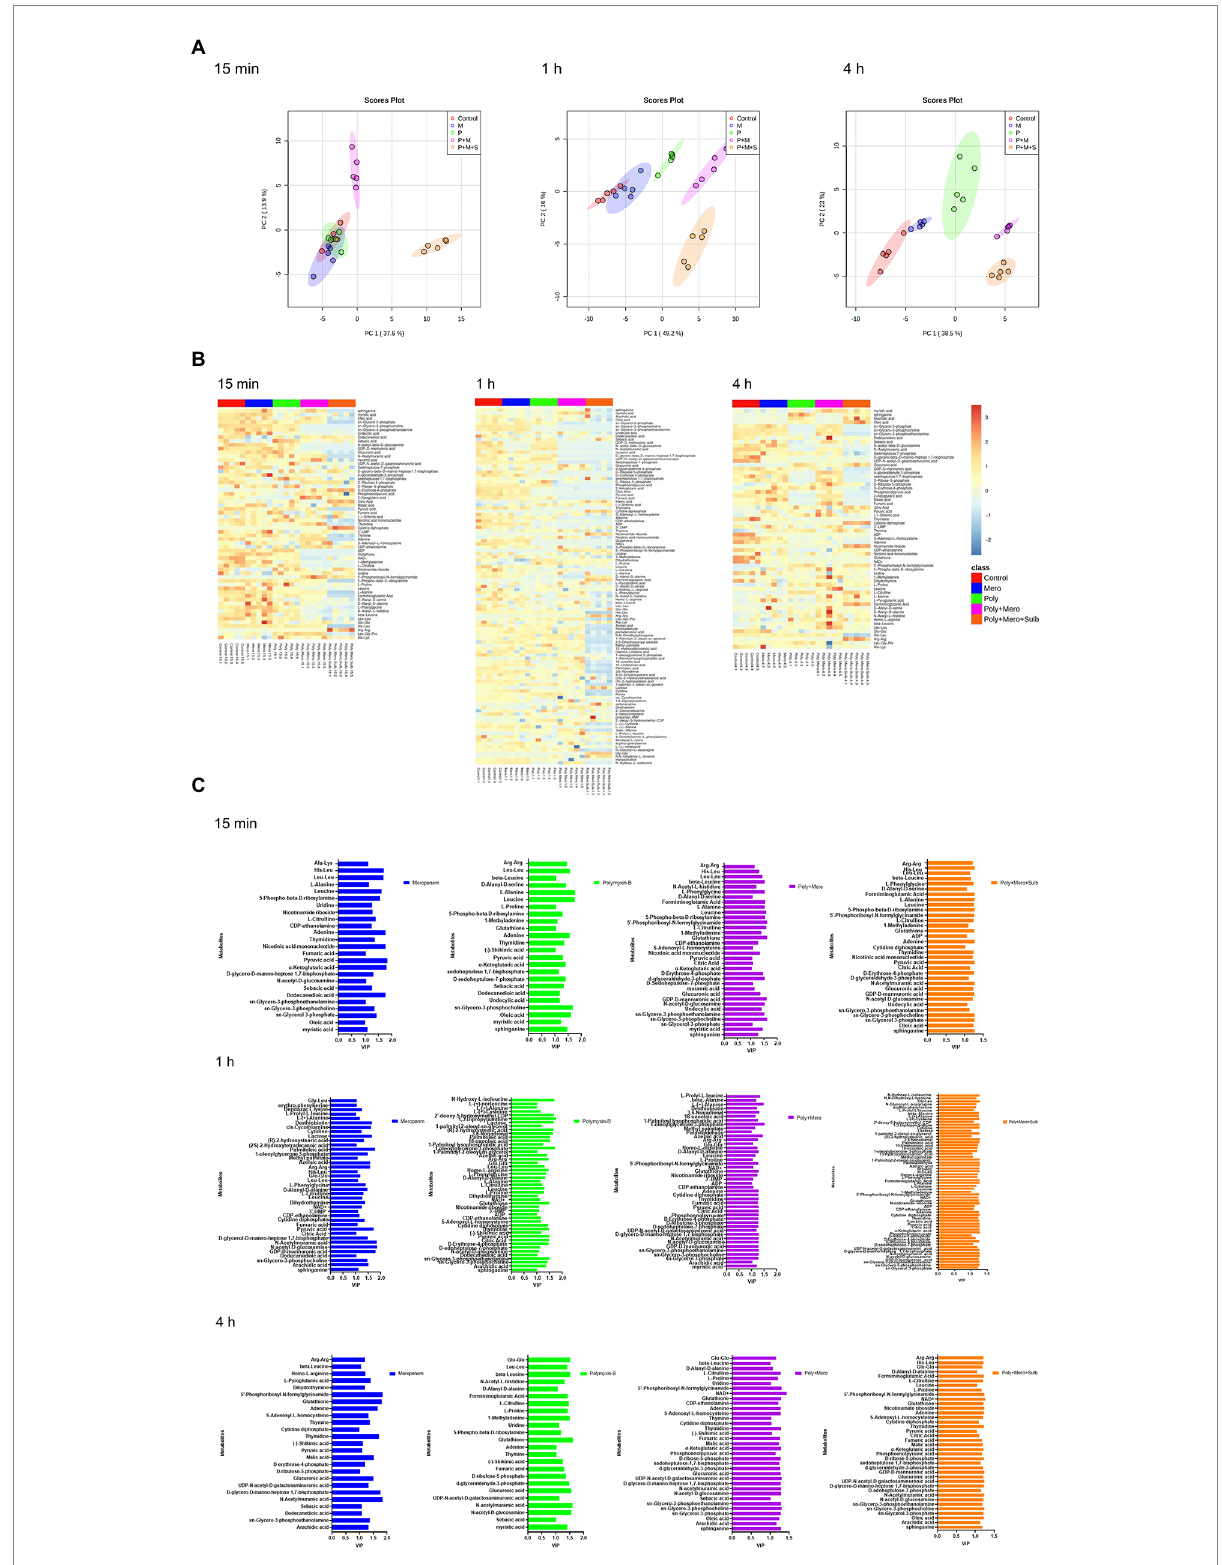
FIGURE 2 Principal component analysis (A) , Heatmap (B) , and variable important in projection >1 (C) profile of MDR Acinetobacter baumannii treated with meropenem and polymyxin-B as monotherapy and in combination with and without sulbactam at 15 min, 1 h and 4